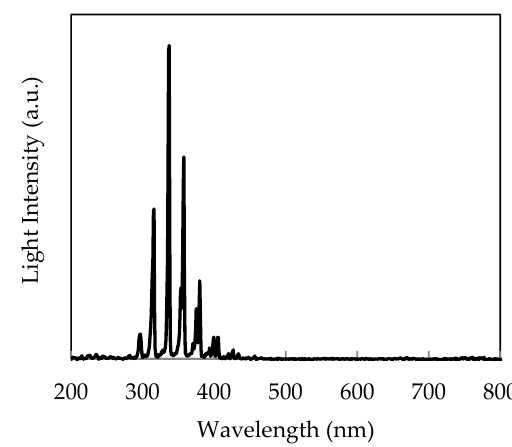
Figure 12. Light intensity spectrum of the corona discharge.